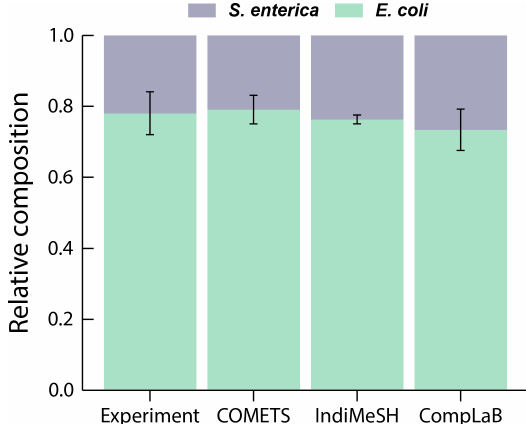
Figure 3. The relative composition of six in vitro experiments and COMETS, IndiMeSH, and CompLaB simulation results after 48h. Error bars represent 1 standard